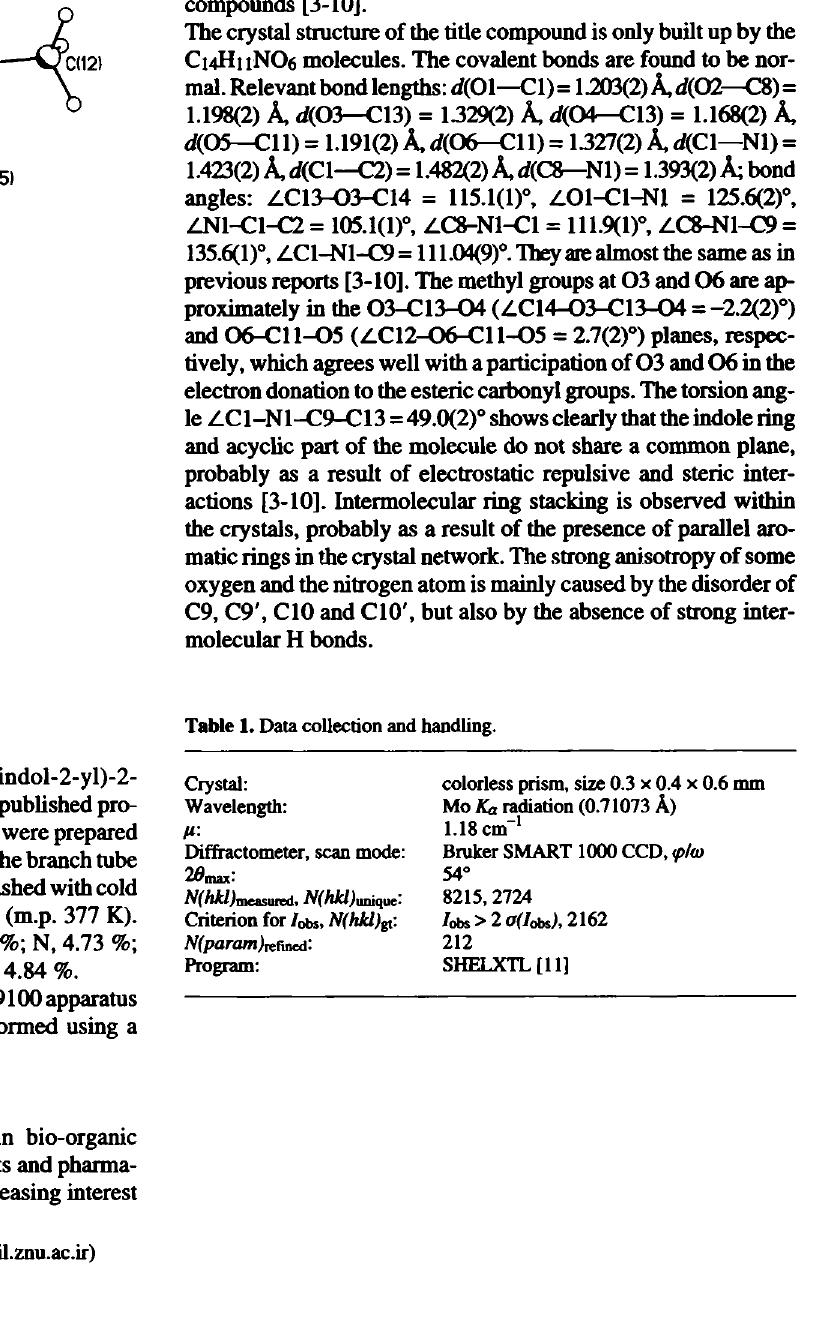
Table 1. Data collection and